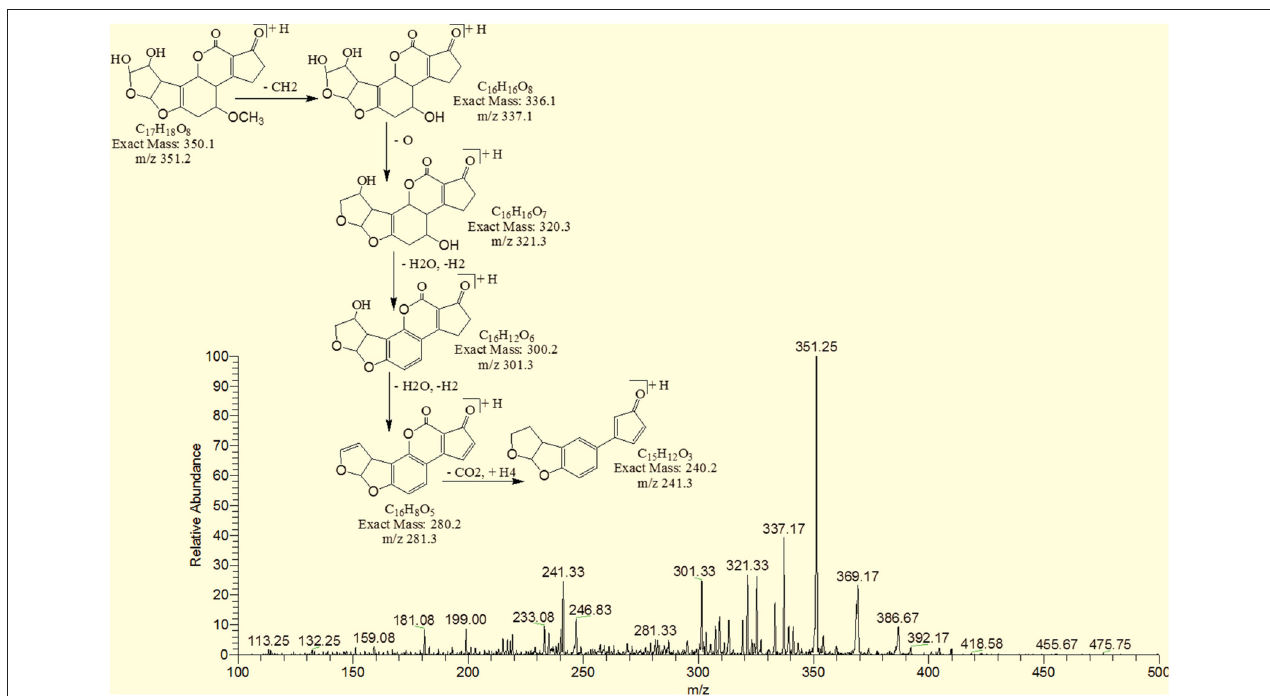
FIGURE 10 | MS/MS spectra and fragmentation pathway of degradation product with